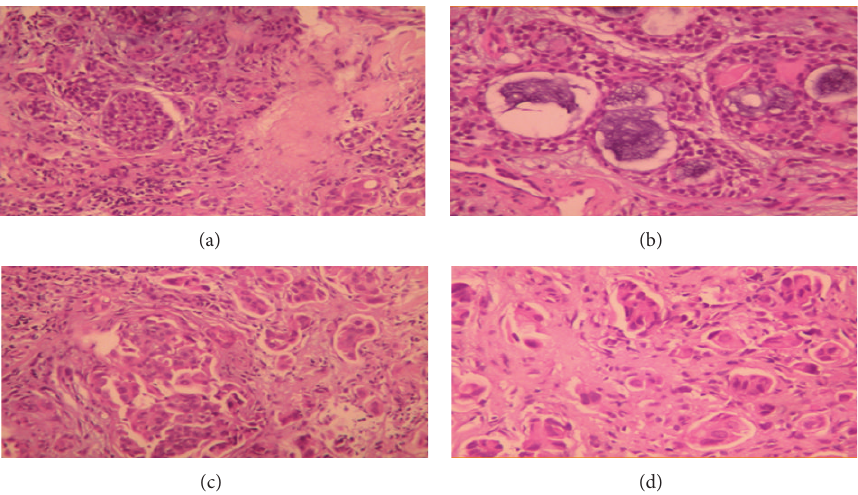
Figure 3: Histopathological examination. (a) and (b) The classical pattern of adenoid cystic carcinoma, with a mixture of cribriform and tubular pattern. (c) and (d) The glandular and solid growth pattern of the adenocarcinoma (NOS).